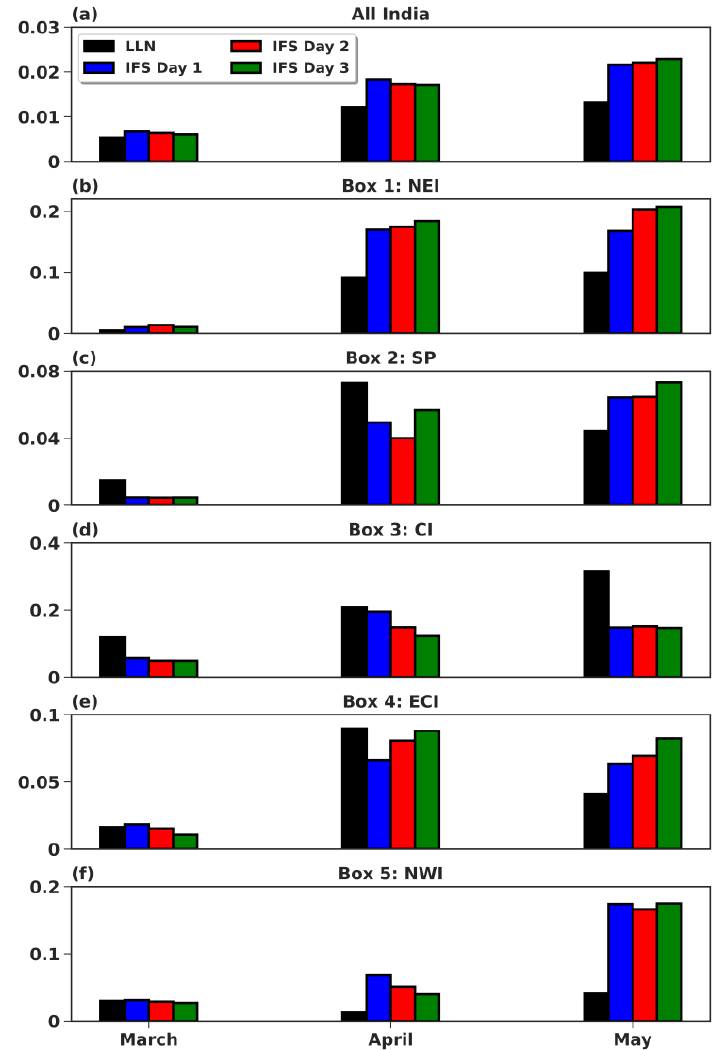
Figure 7. MAM 2020 mean monthly total lightning flash density (km − 2 ) averaged over ( a ) All India (40 ◦ N–10 ◦ S, 50 ◦ E–100 ◦ E), ( b ) Box 1: NEI, ( c ) Box 2: SP, ( d ) Box 3: CI, ( e ) Box 4: ECI and ( f ) Box 5: NWI.